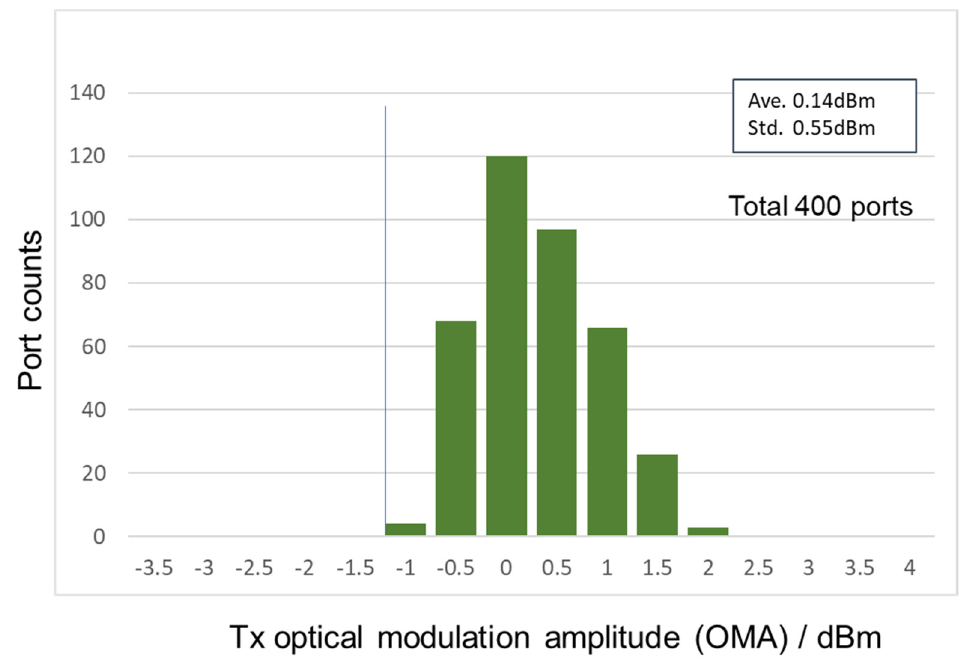
Figure 12. Distribution of optical modulation amplitude as measured on the outputs of the IOCore Tx optical Tx optical pins.